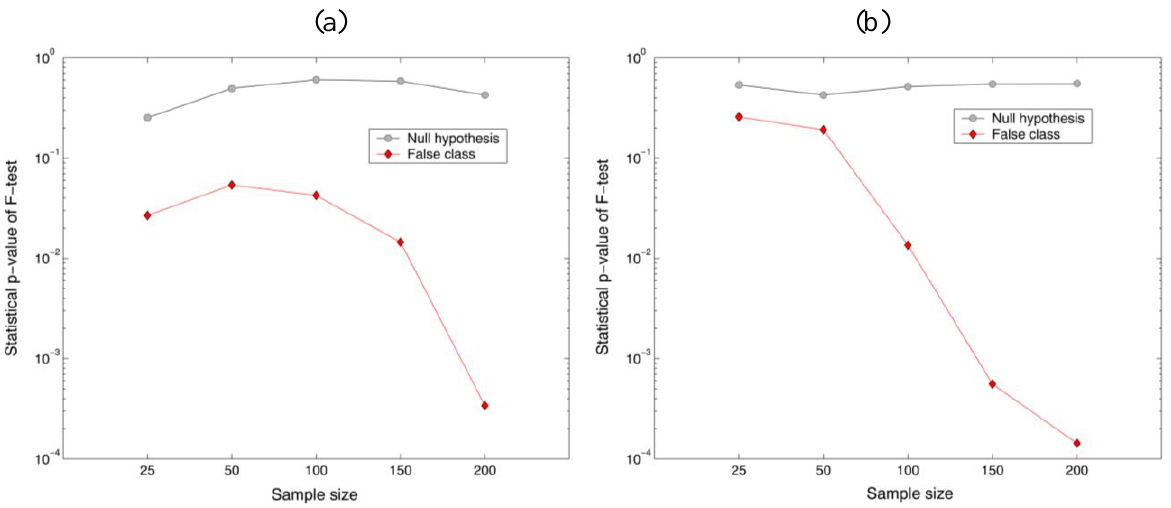
Figure 5. The average statistical p-value calculated from the parametric F-test. (a) real part and (b) imaginary part in the reconstructed image. Reference: Oscillatoria bacteria. False class: Diatom